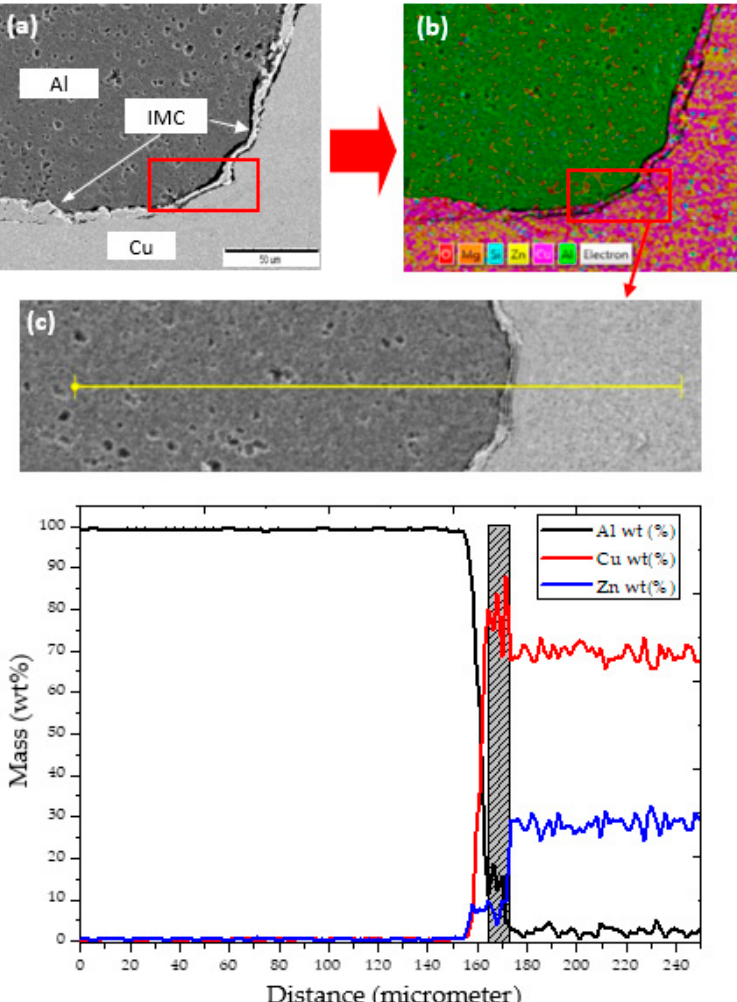
Figure 14. Material characterisation analysis for sample 14, ( a ) field-emission scanning electron microscopy (FESEM) analysis, ( b ) energy-dispersive X-ray spectroscopy (EDS) mapping analysis, and ( c ) EDS line scanning analysis.